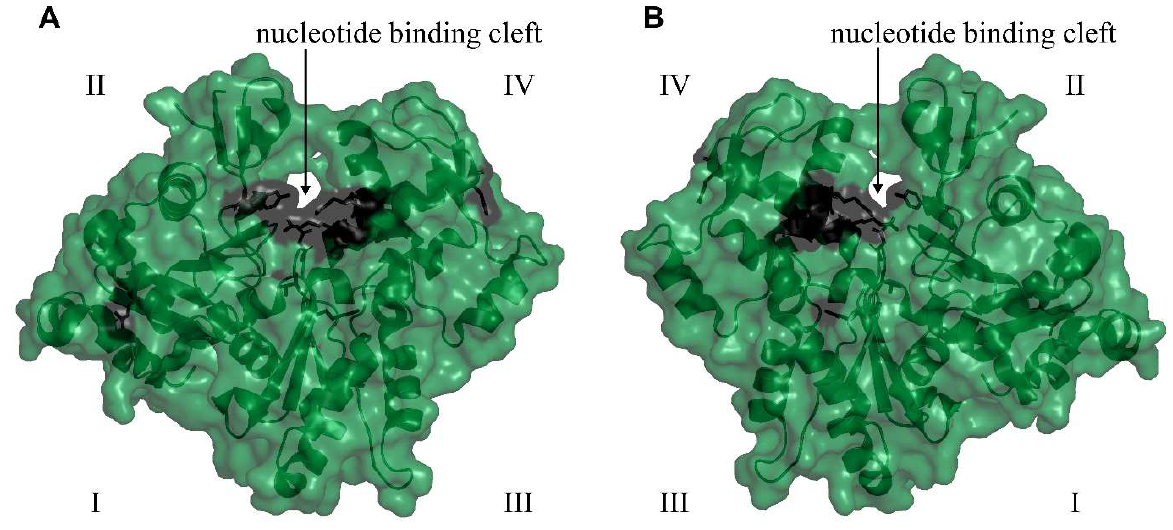
Figure 2. Surface model of native G-actin and its subdomains I–IV (green, PDB: 3HBT) with reported sites of amino acid mutations (black), each leading to the inhibition of latrunculin binding (see SI Table S3). ( A and B ) Front and back view of G-actin.